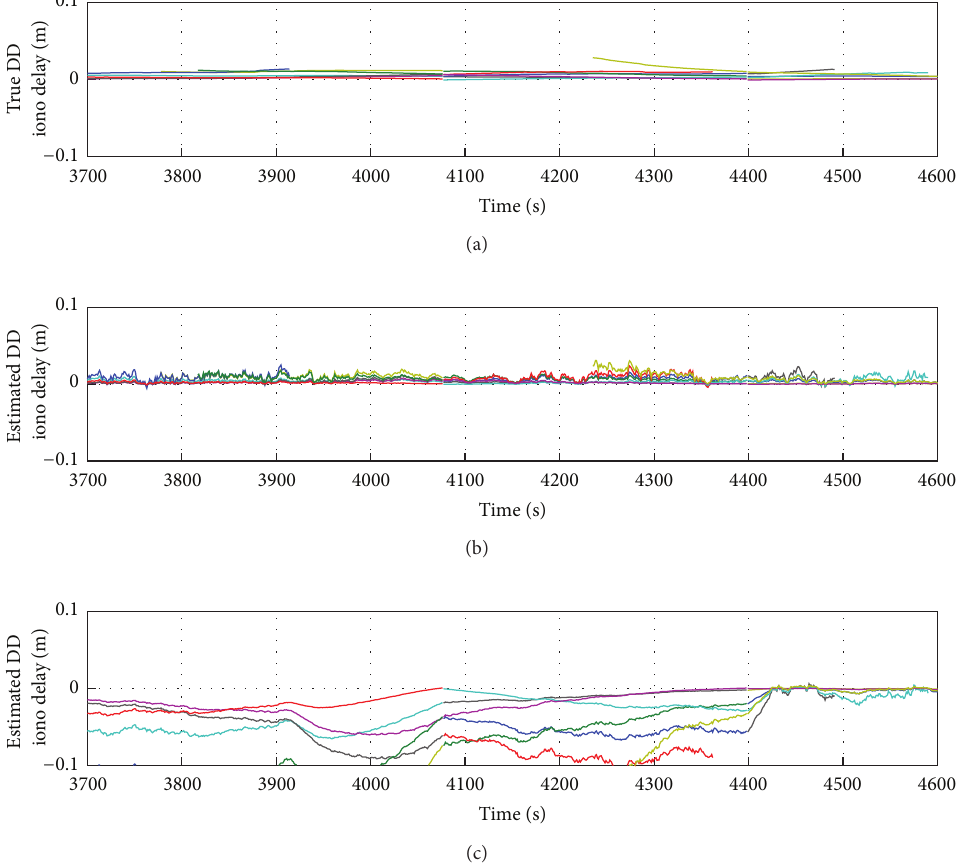
Figure 8: True DD ionospheric delays (a) versus estimated DD ionospheric delay by CDGPS + ISL (b) and CDGPS only